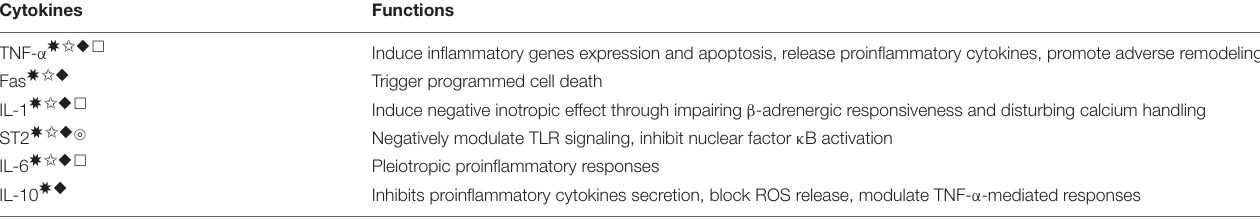
TABLE 1 | Cytokines in heart failure. Cytokines Functions